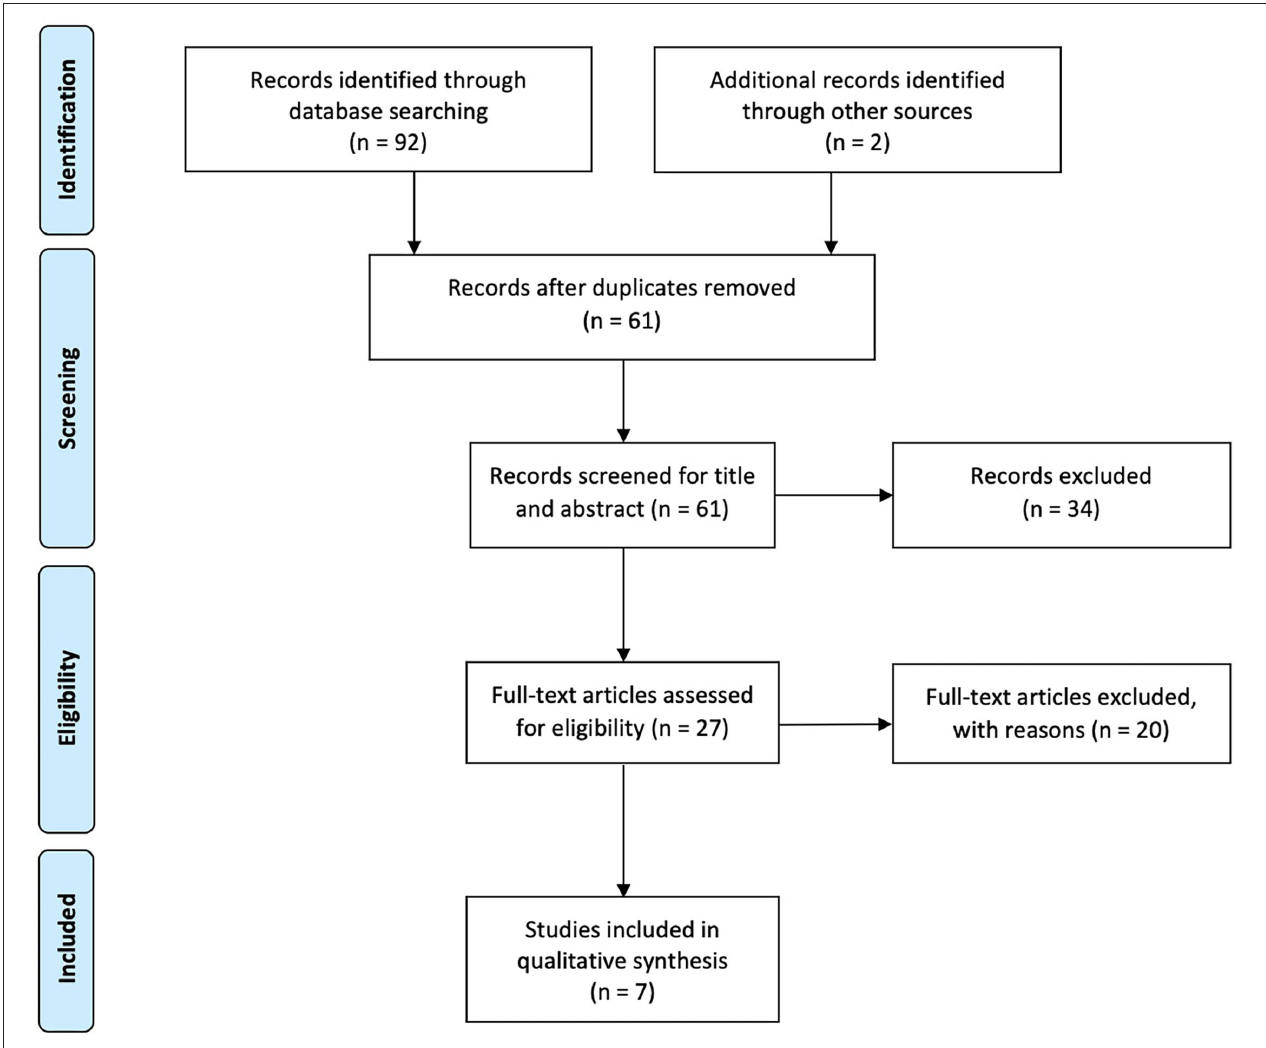
FIGURE 1 | The Preferred Reporting Items for Systematic Reviews and Meta-Analyses (PRISMA) flow